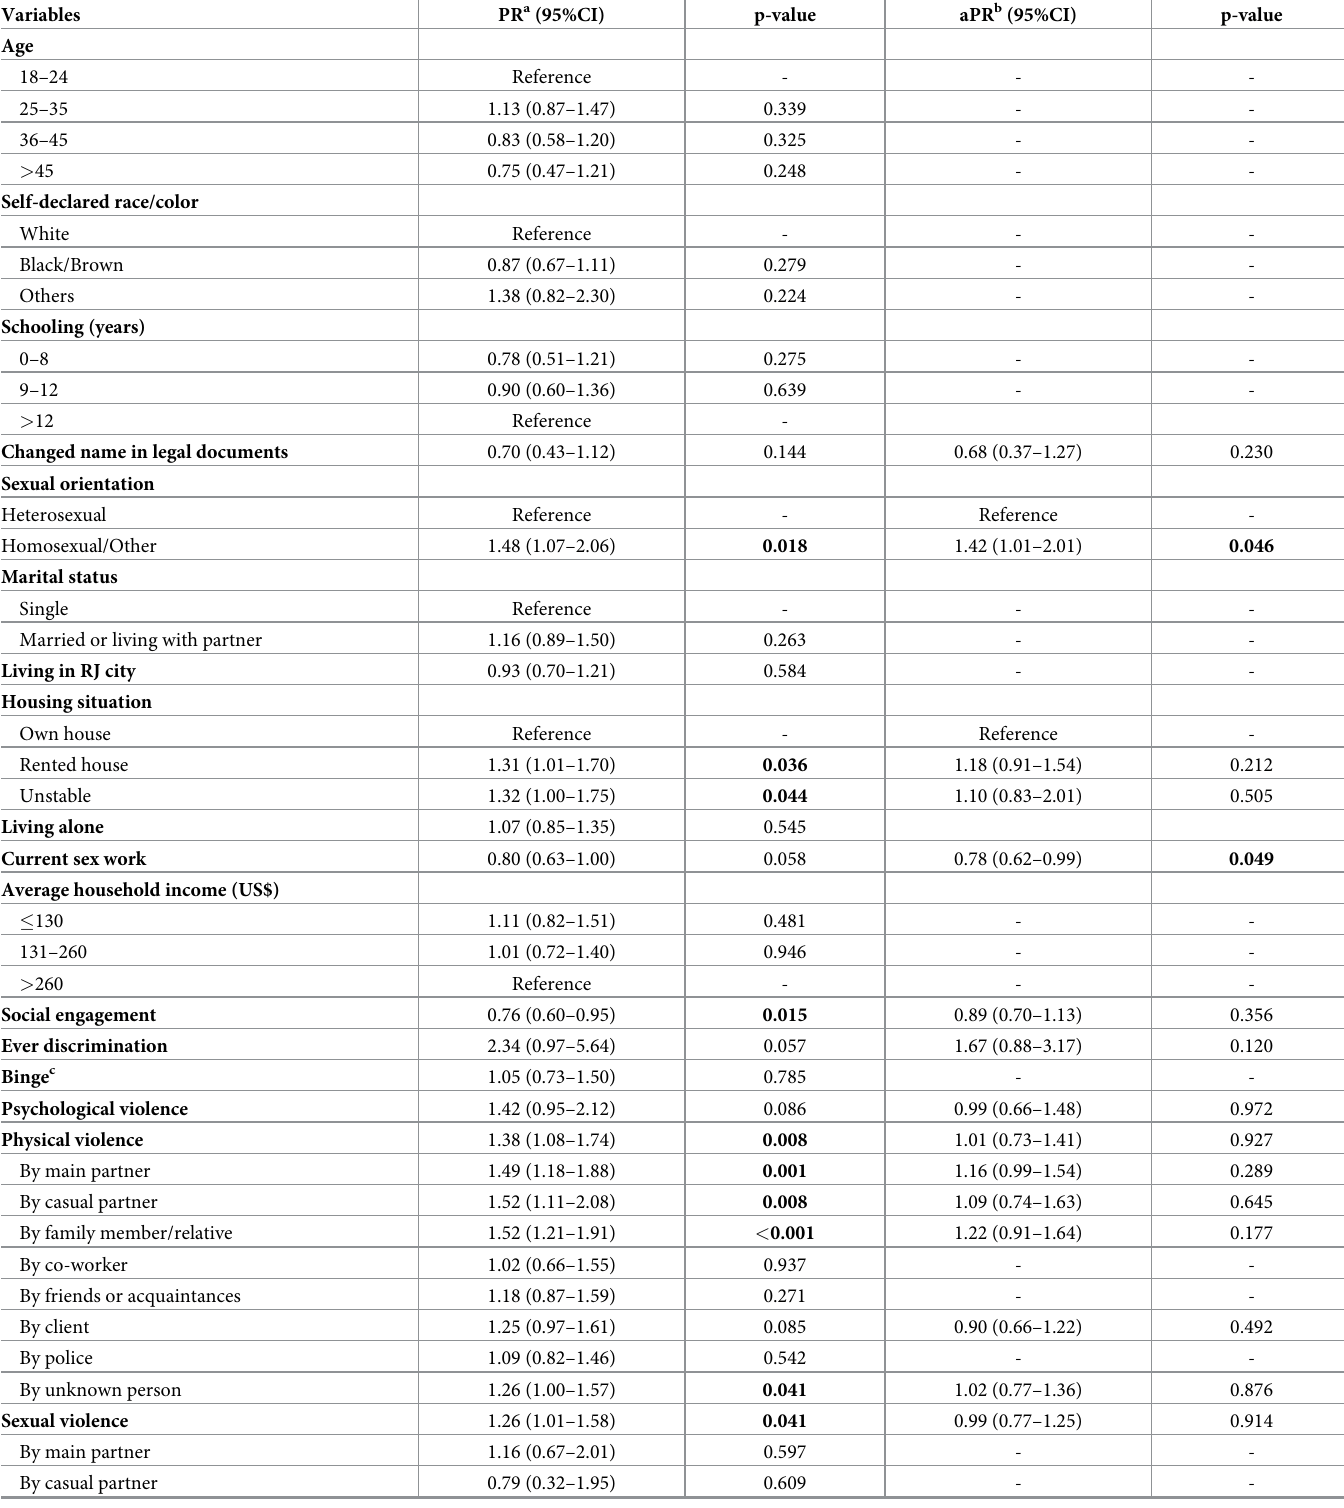
Table 2. Crude and initial model of adjusted prevalence ratio of lifetime suicidal ideation among trans women in Rio de Janeiro, Brazil,